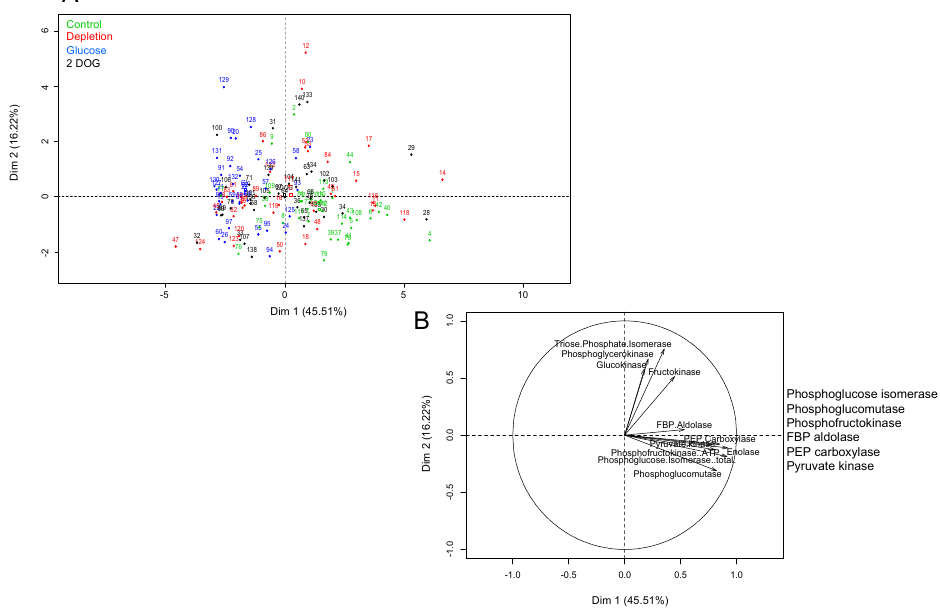
Figure 11. Principal component analysis (PCA) of measured enzyme activities in embryogenic WT and 35S::VvMSA-RNAi cells. ( A ) Individual map. ( B ) Correlation circles. The overall data of enzyme activity measurements were used. Studied conditions: Control-cells that were transfected in the complete GM + culture medium for 30 h or 48 h. Depletion-cells that were transfected in the minimal GM° culture medium for 30 h or 48 h. Glucose-and 2DOG-cells that were transfected in the minimal GM° culture medium for 24 h and treated with 10 mM glucose or 0.9 mM 2DOG for additional time periods of 6 or 24 h. Green-control; red-depletion; blue-glucose; black-2DOG. Three independent biological repetitions were carried out for each of the studied conditions, with at least three technical replicates per biological repetition.